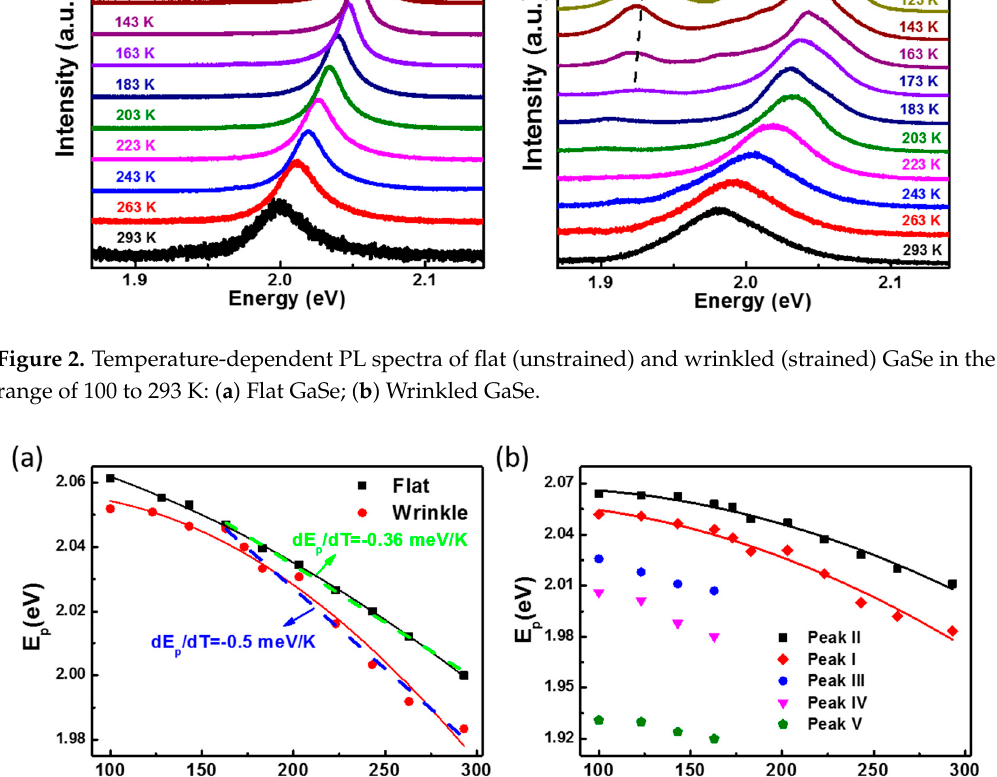
Figure 3. The temperature-dependent evolution of PL peaks from flat (unstrained) and wrinkled (strained) positions. ( a ) Black squares: the major PL emission from flat position. Red dots: peak I from the wrinkled position. The solid curves are the least-squares fits of data with the Varshni empirical equation. The dashed lines are the linear fits; ( b ) The five PL peaks from the wrinkled position.